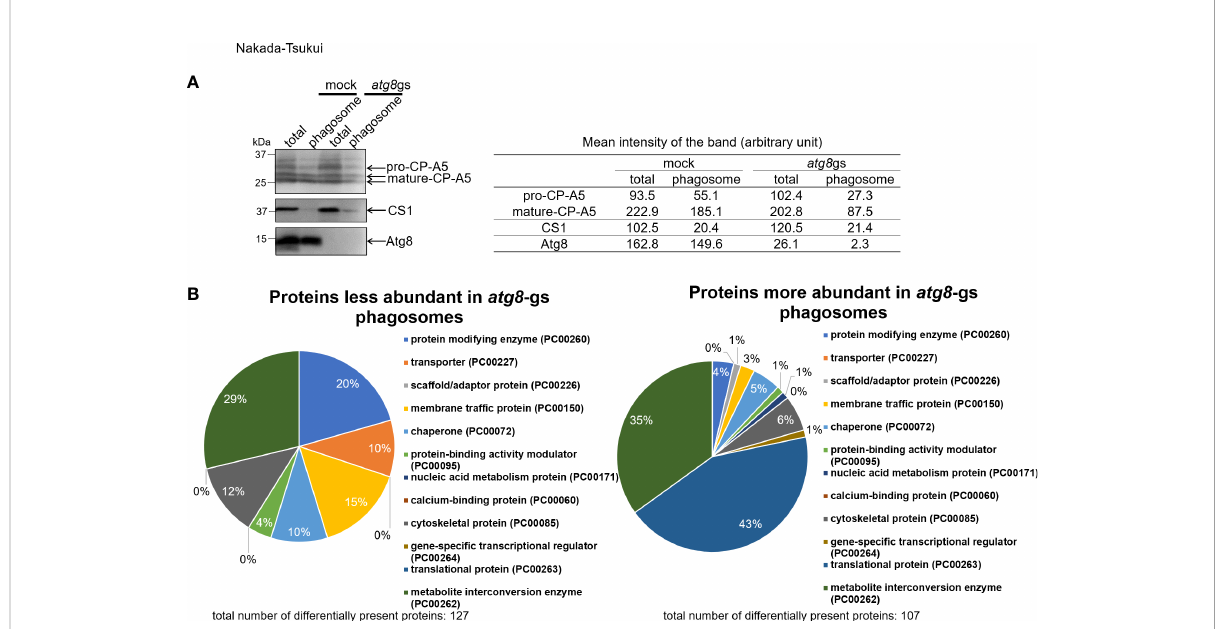
FIGURE 1 Evaluation of quality of puri fi ed phagosome and protein class distribution of less- and more- abundant proteins in atg8 -gs strain. (A) Immunoblot analysis of total (total) and puri fi ed phagosome (phagosome) protein. E histolytica cell lysate from mock and atg8 -gs strains are loaded, 20 m g for total and 2 m g for phagosome protein, were separated by SDS-PAGE. Each protein was detected with anti-EhCP-A5, anti-CS1, ad anti-Atg8 antisera, respectively. Quanti fi cation of the mean intensity (the total intensity per the area) of the bands is shown in the right table. (B) Protein class distribution of less- and more- abundant phagosomal proteins in atg8-